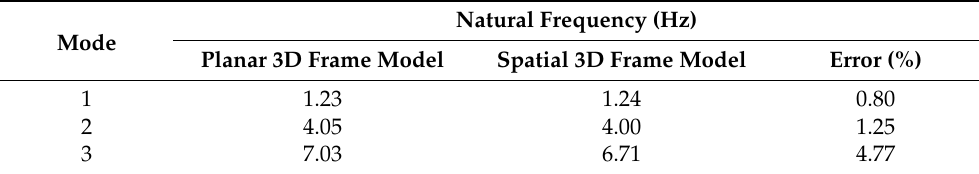
Table 3. The first three frequencies of the planar and spatial 3D frame